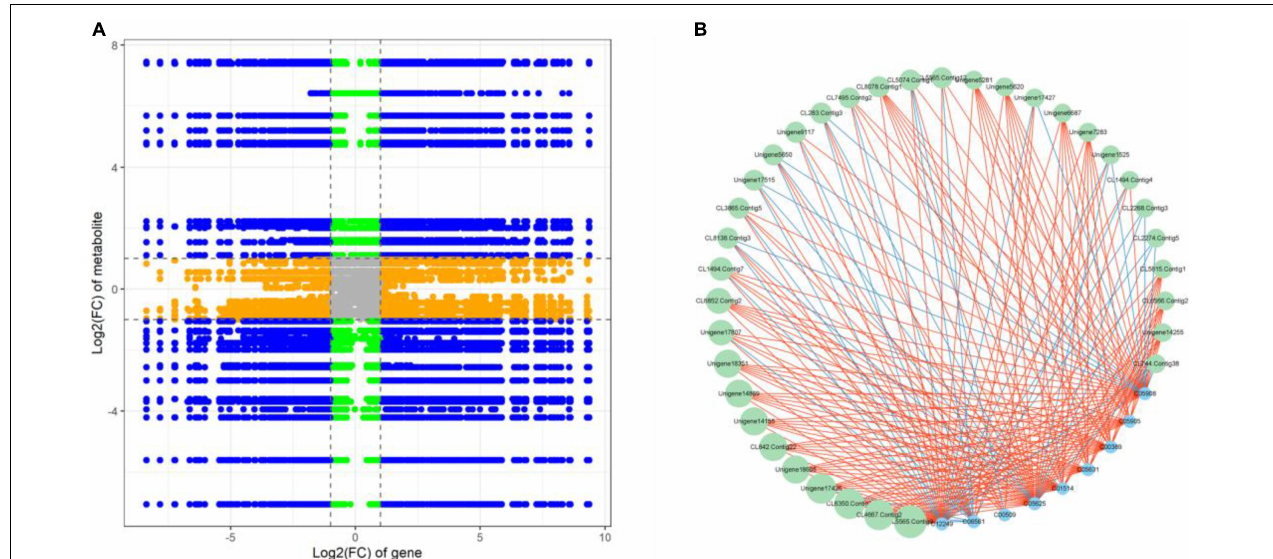
FIGURE 6 | (A) A nine-quadrant diagram showing the association of DEGs and DAMs with FR and LF libraries. (B) Connection network between DEGs (green circles) and DAMs (blue